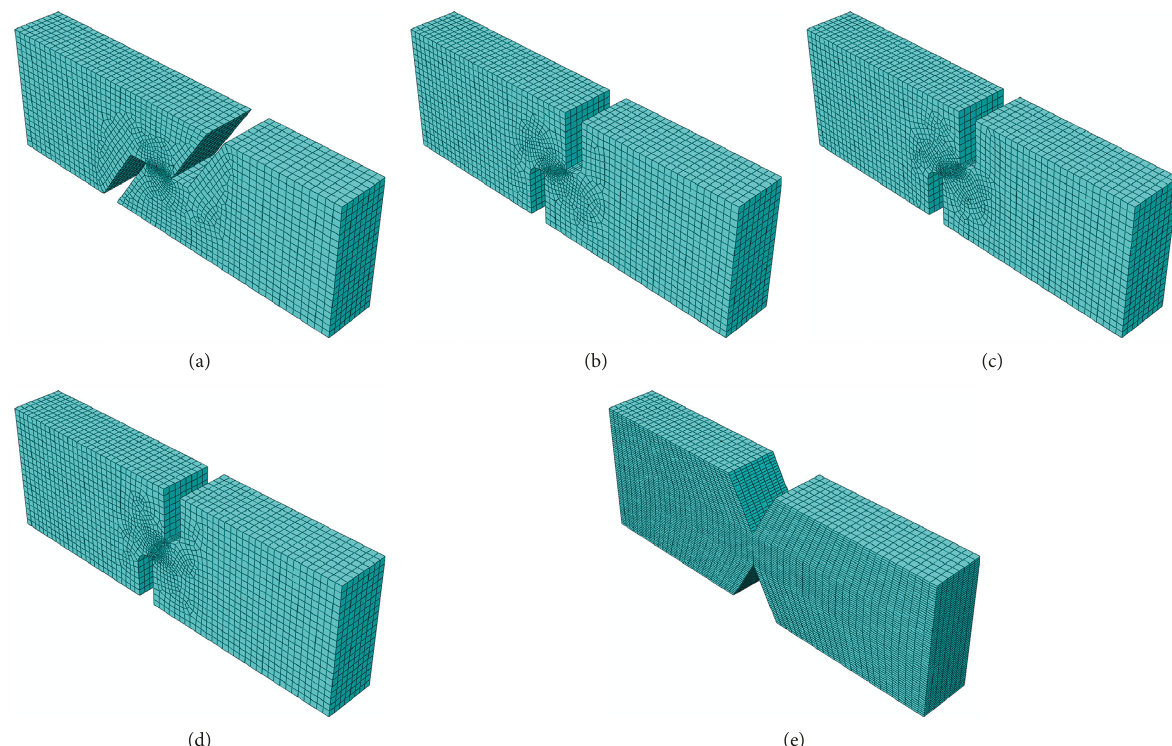
Figure 12: The 3D finite element model meshes of (a) 0 ° , (b) 30 ° , (c) 45 ° , (d) 60 ° , and (e) 90 °